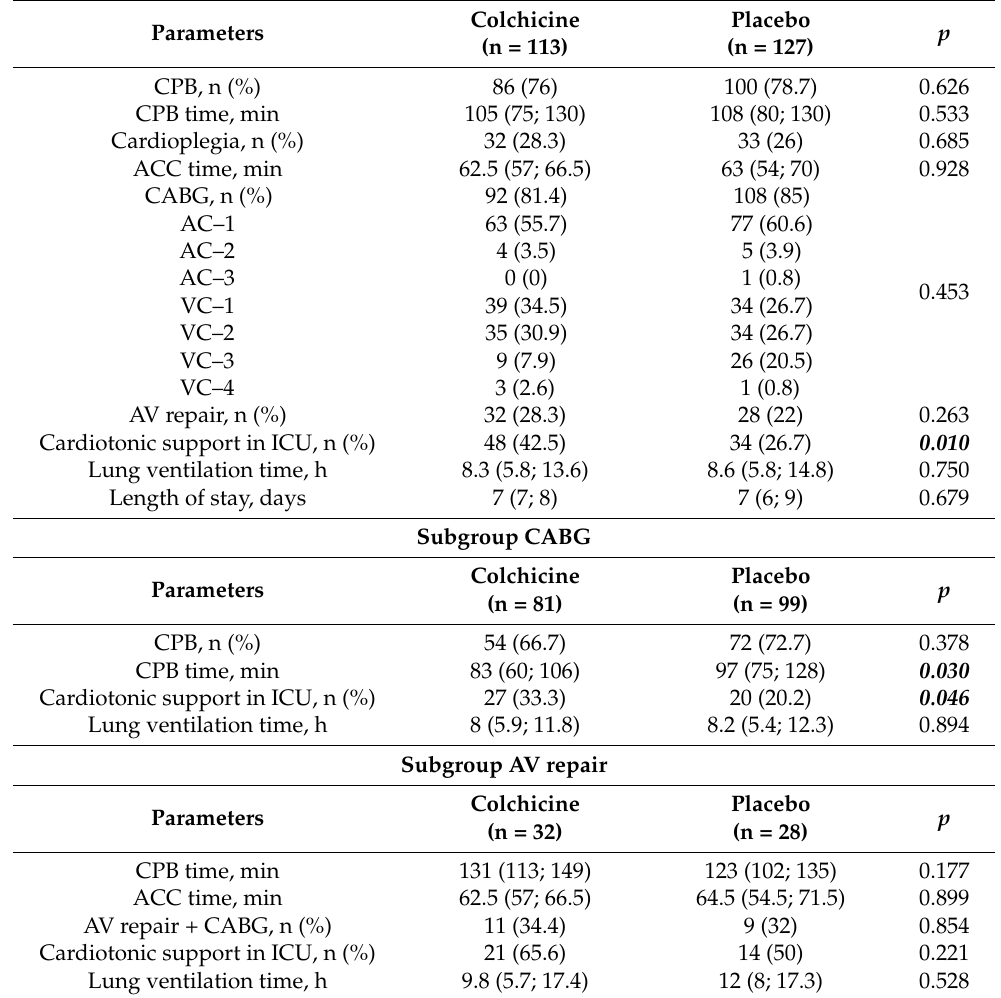
Table 2. Operative and postoperative data.